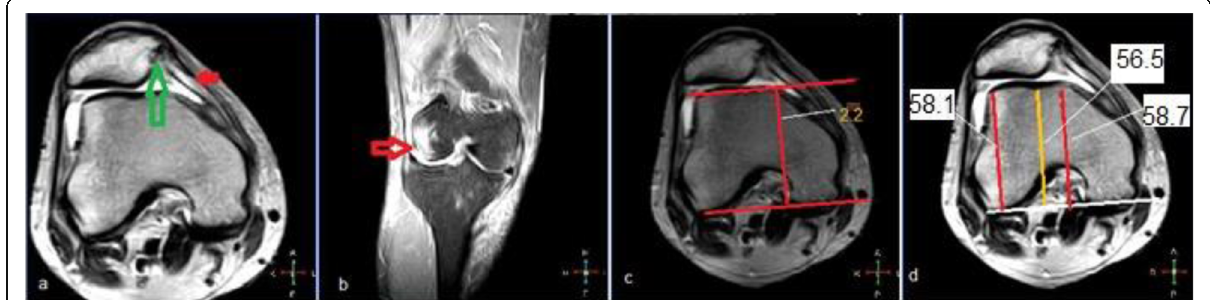
Fig. 7 a – d MRI images for transient patellar dislocation with kissing bone contusions of the medial patellar facet and lateral femoral condyle and an interstitial tear of the medial patellar retinaculum as well as a trochlear dysplasia type B (predisposing factor). a Axial T2WI demonstrated fluid signal within the thickened medial patellar retinaculum (red arrow) and medial patellar surface osteochondral injury (green arrow). b Coronal STIR demonstrated a bright signal at the lateral femoral condyle (bone contusion) (red arrow). c, d Axial T2WIs demonstrated a trochlear depth of about 2 mm and a lateral inclination angle of